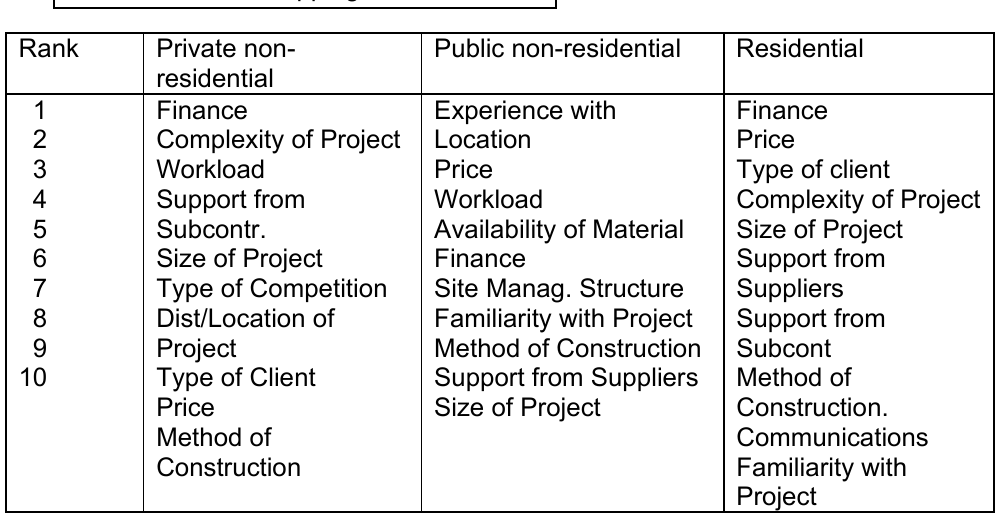
Table 1: Rank of importance given to the ten most important aspects of environment and project by contractors working in different